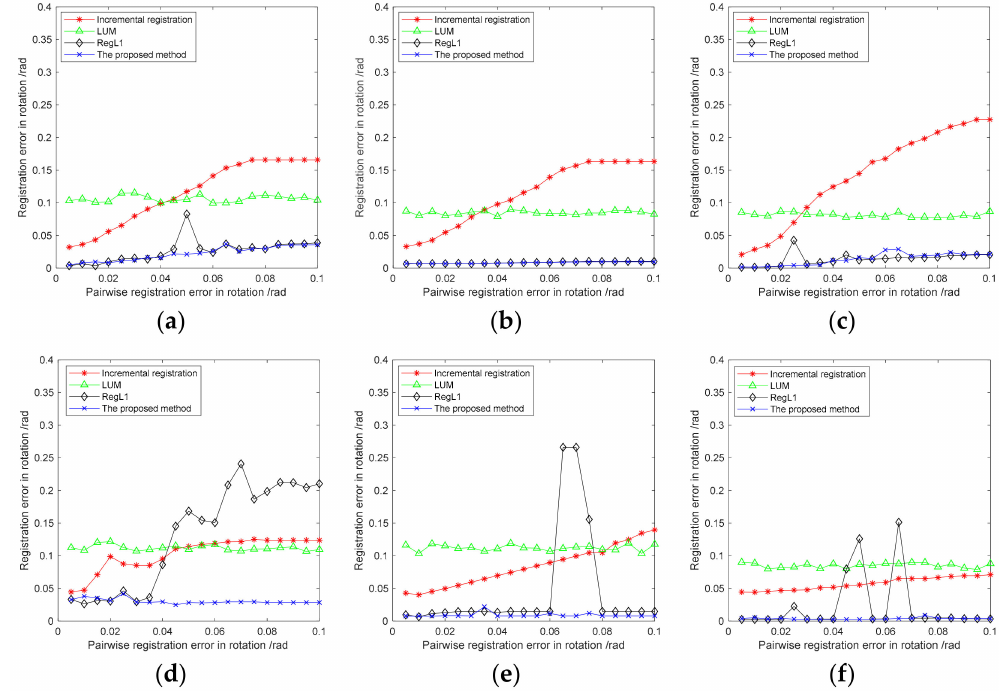
Figure 9. The relation between registration error and the pairwise registration error: ( a ) Bunny, ( b ) Armadillo, ( c ) Dragon, ( d ) MRO, ( e ) Skylab, and ( f )